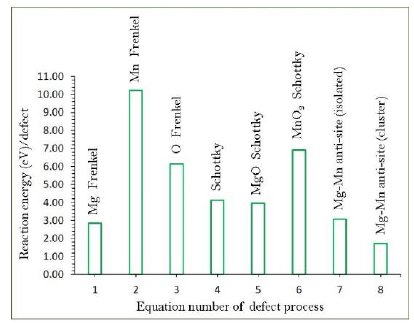
Figure 2. Calculated intrinsic defect energies in Mg 6 MnO 8 . Figure 2 . Calculated intrinsic defect energies in Mg 6 MnO 8 .